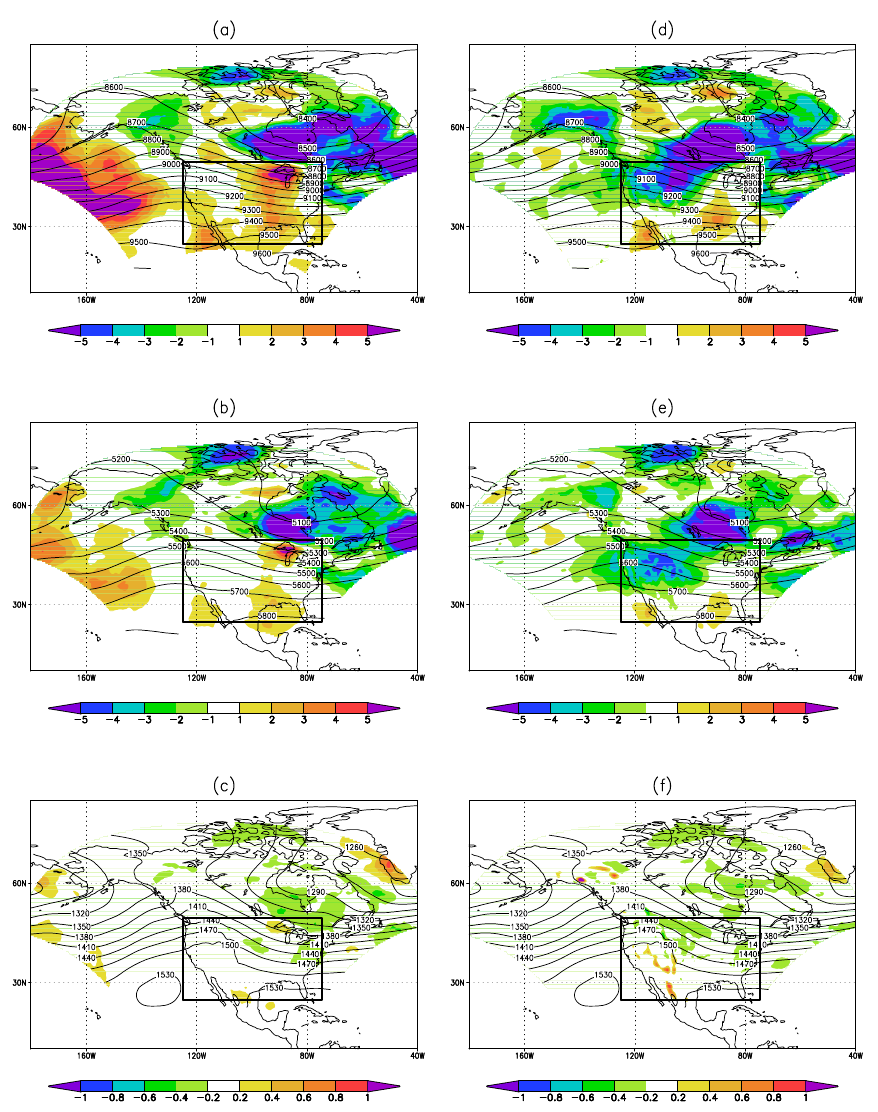
Fig. 9. The difference between the root-mean square errors of the 48-h forecasts started from the analyses obtained by Strategy 4 and Strategy 3. Results are shown for the limited area geopotential height forecasts at the 300hPa (a) and the 500hPa (b) , and the limited area temperature forecasts at 850hPa (panel c ); for the global geopotential height forecasts at 300hPa (d) and 500hPa (e) and the global temperature forecast at 850hPa (f) . Strategy 4 provides more accurate forecasts where the shades indicate positive values. Contour show the time mean of the true geopotential height at the given